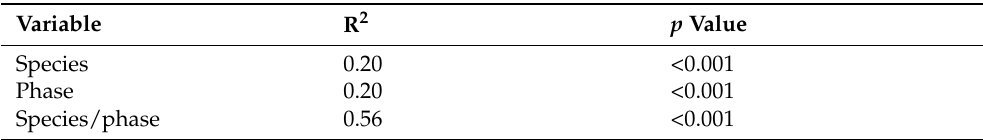
Table 3. Permutational multivariate analysis of variance applied to variables to compare the variance in the volatile profiles of Malassezia